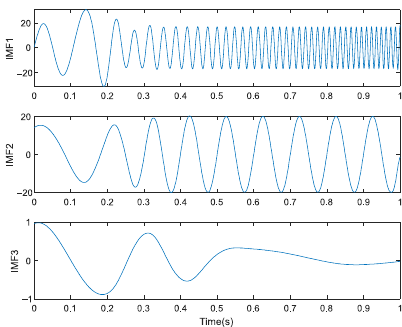
Figure 12. EMD decomposition.